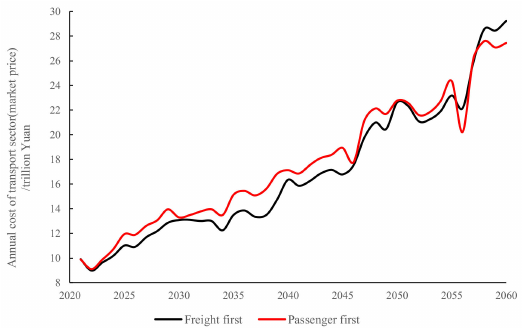
Figure 14. Annual cost of the transport sector under two